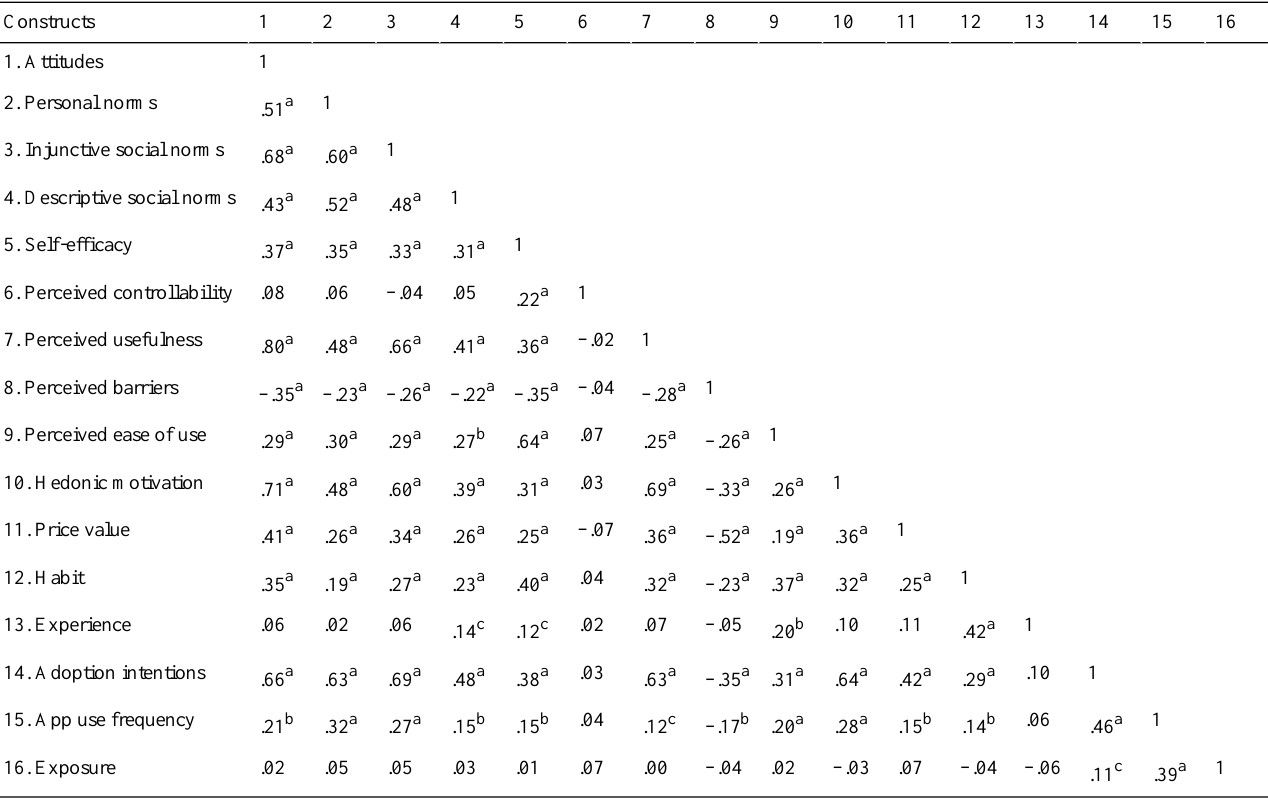
Table 2. Bivariate correlations between core constructs of health behavior models, technology acceptance, adoption intentions, and frequency of use of COVID-19 contact tracing